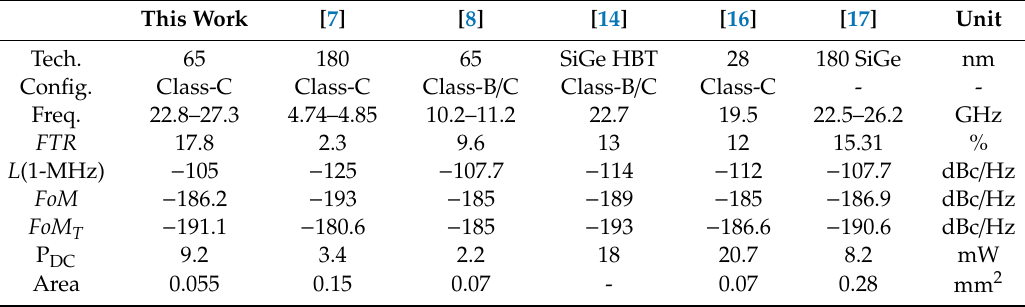
Table 2. Performance comparison with published class-C